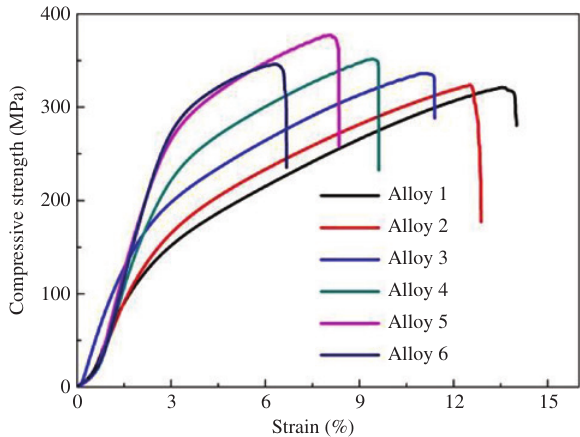
Figure 5: Compressive stress-strain curves of the base Mg alloy (alloy 1) and FAC/Mg alloy degradable composites (alloy 2, alloy 3, alloy 4, alloy 5 and alloy 6).